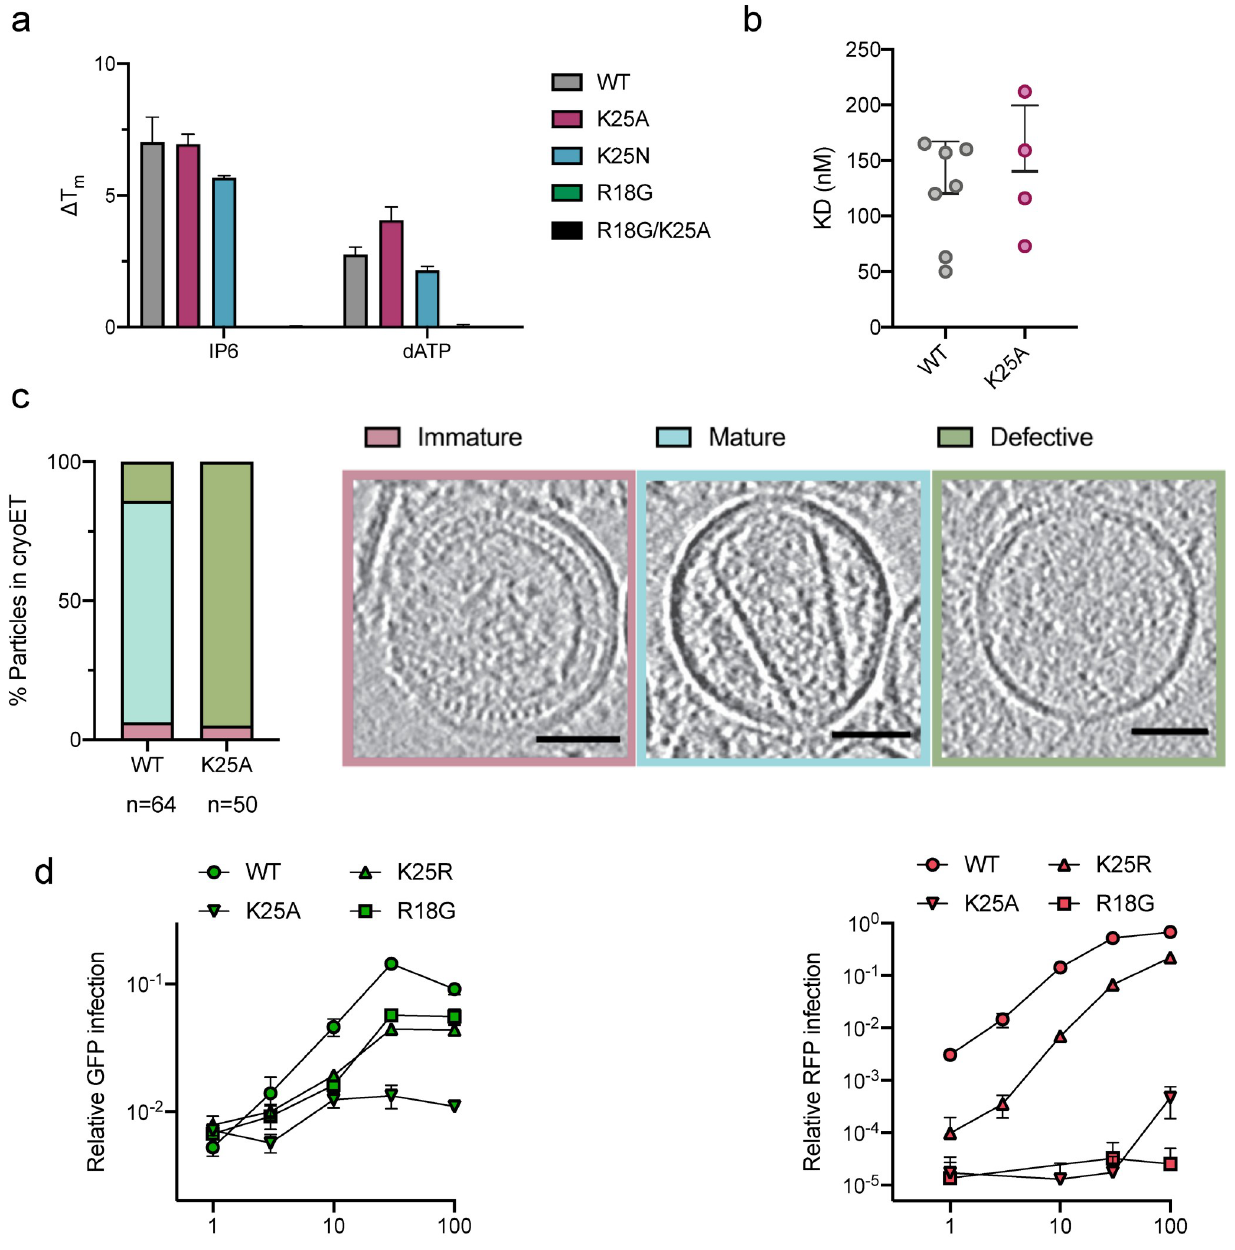
Fig 3. K25 is required for the production of HIV virions with mature capsid cores. (a) Changes of NanoDSF-derived melting temperature ( Δ Tm’s) of K25A, K25N, R18G and R18G/K25A in the presence of different polyanions compared to the respective disulfide-stabilised hexamers in absence of ligands. Error bars depict mean ± SD of technical replicates. (b) Dissociation constants (K D ’s) of Atto488-ATP binding to self-assembled CA A204C/A92E cones determined by TIRF microscopy. (c) Cryo-ET analysis of infectious WT or K25A HIV virions. Virions were classified as either immature, mature or defective and slices through representative tomograms of each are shown. Scale bars, 50 nm. A total of 64 WT and 50 K25A viral particles were analysed and the frequency of each phenotype is plotted as a percentage. Immature viral particles are labelled in pink, mature in blue, and empty in green. (d) TRIM5 abrogation assay. Cells expressing Rhesus TRIM5 were infected with a consistent dose of WT GFP-expressing virus and increasing doses of RFP-expressing WT, K25A and K25R viruses. The level of infection of each virus (green symbols for GFP, red symbols for RFP) was determined as the proportion of cell area that was GFP or RFP positive. Increasing doses of WT RFP virus results in an increase in RFP positive cells but also in GFP positive cells, because TRIM5 becomes saturated with RFP virus and no longer restricts infection by the GFP virus. Viruses that do not contain capsids capable of recruiting and maintaining TRIM5 binding will not saturate. Error bars depict mean ± SD of three replicates from one experiment representative of two independent experiments.